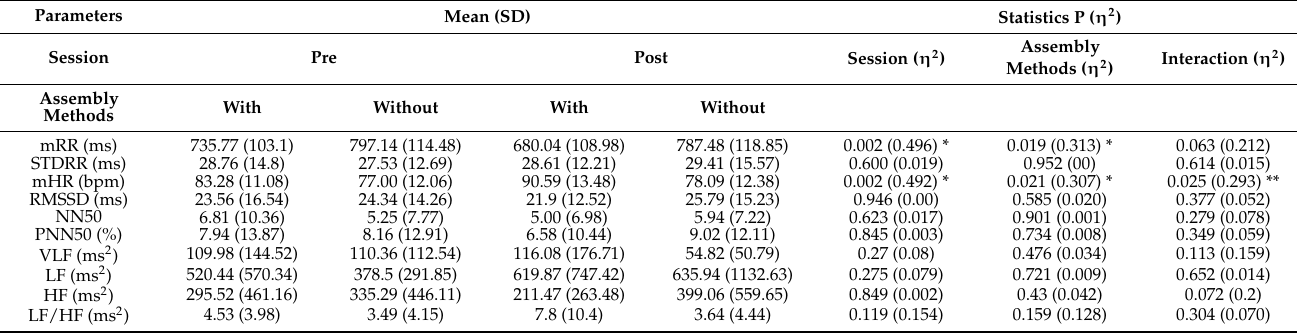
Table 2. Mean (standard deviation) values of the HRV before and after assembly task with and without pedaling. Parameters